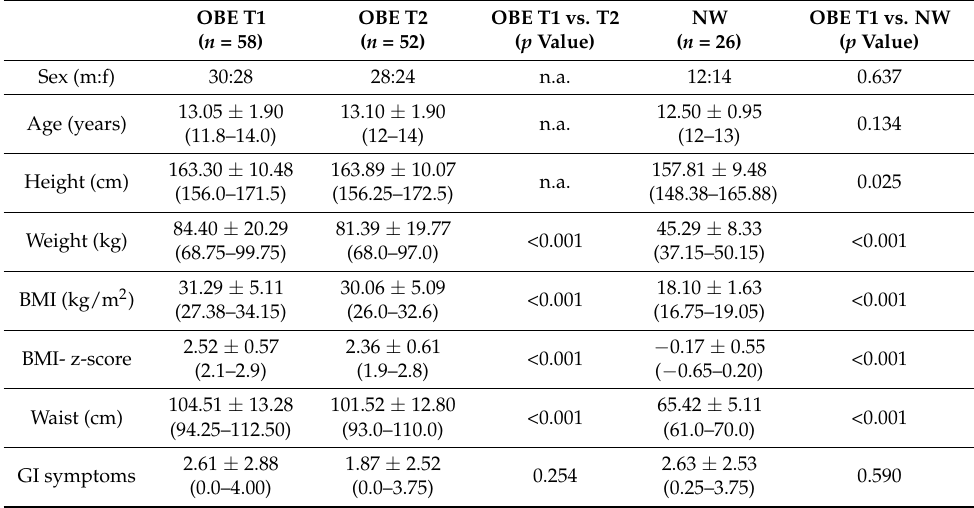
Table 1. Sample description of children with obesity (OBE) before (T1) and after (T2) weight loss, and of normal-weight control children (NW).